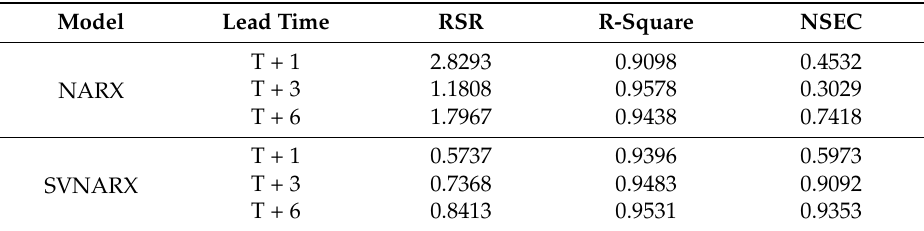
Table 2. Error analysis of the predicted total accumulative